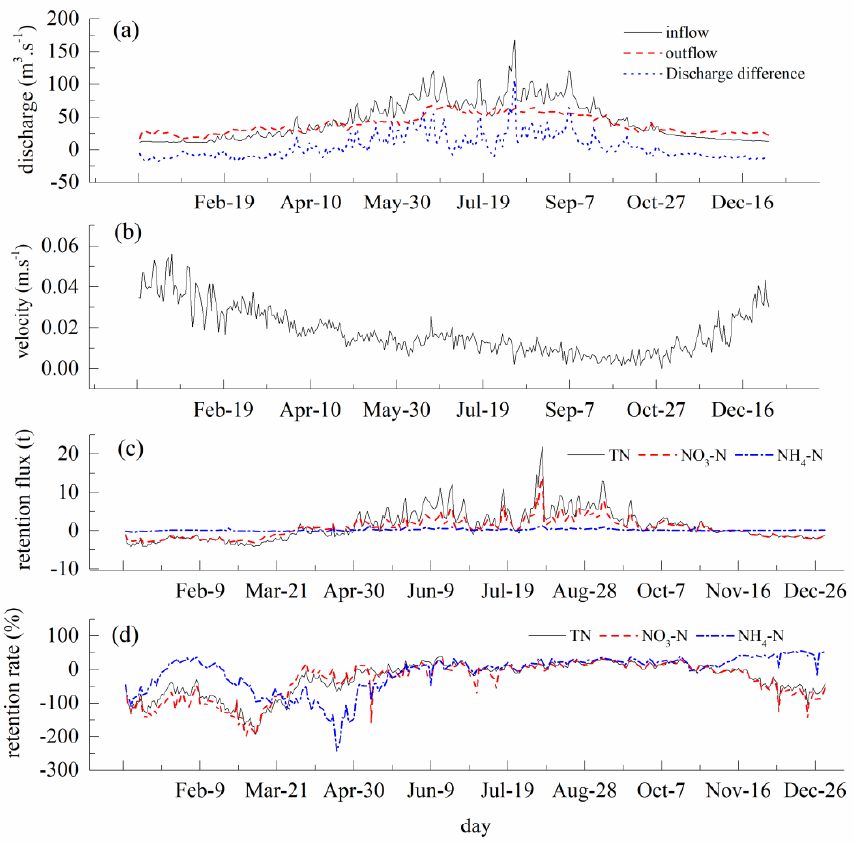
Figure 5. Daily variation of hydrological condition and nitrogen retention effects in Shanmei Reservoir. ( a ) Discharge of inflow and outflow; ( b ) velocity; ( c ) retention flux of TN, NO 3 -N, and NH 4 -N; ( d ) retention rates of TN, NO 3 -N, and NH 4 -N.